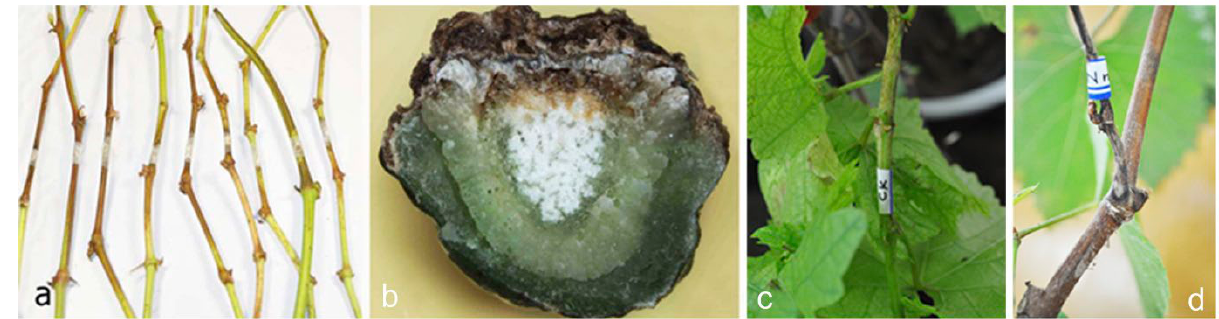
Figure 3. a. Detached grapevine shoots artificially infected with Neofusicoccum mangiferae (after 7 days); b. Cross section of inoculated shoots (after 7 days); c, d. Pathogenicity test on standing grapevines. (c) Control. (d) Cane death 30 days after